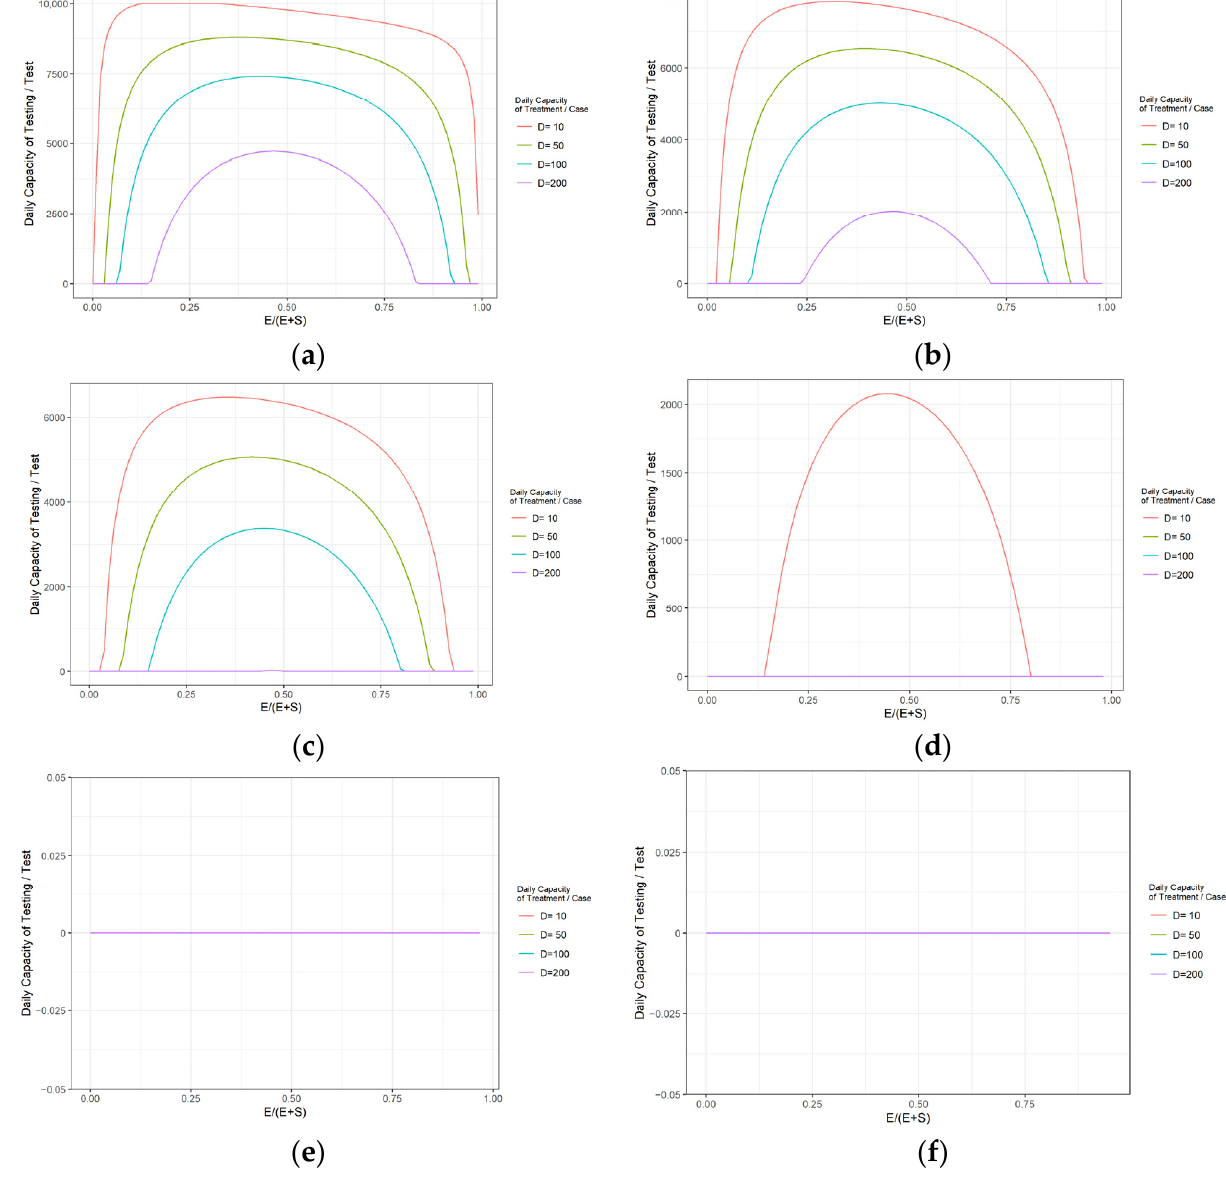
Figure 5. Relationship between the daily testing capacity of the epidemic and the potential level of the epidemic development. ( a ) S + E = 9999, I = 0; ( b ) S + E = 9000, I = 1000; ( c ) S + E = 8000, I = 1000; ( d ) S + E = 5000, I = 1000; ( e ) S + E = 3000, I = 1000; ( f ) S + E = 2000, I = 1000.